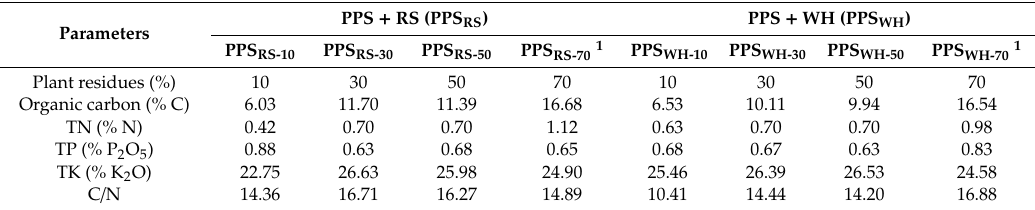
Table 2. Chemical composition of organic fertilizer produced from Pangasius pond sediments (PPS) mixed with rice straw (RS) or common water hyacinth (WH).